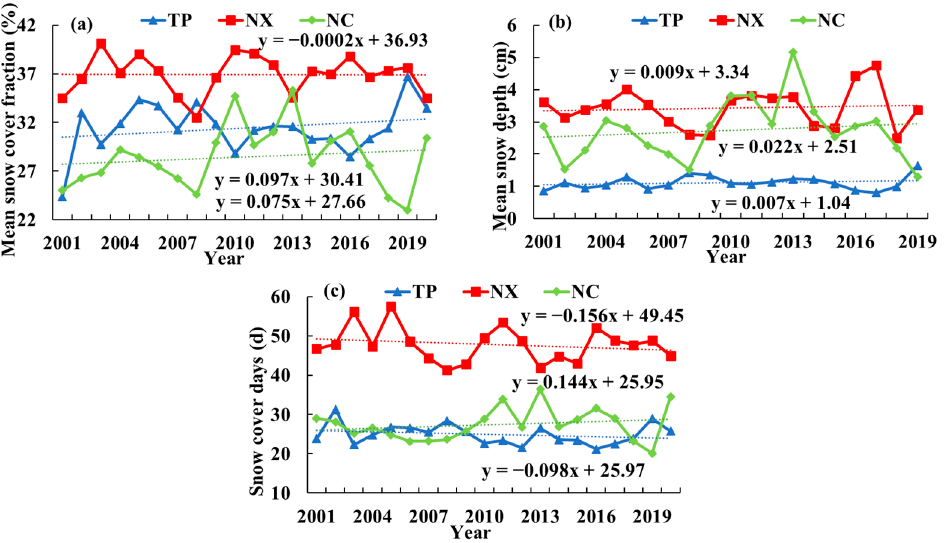
Figure 2. Annual variation in SCF ( a ), SD ( b ), and SCDs ( c ) in the TP, NX, and NC from 2001 to 2019 or 2020. The blue line represents the TP, the red line represents NX, and the green line represents NC.